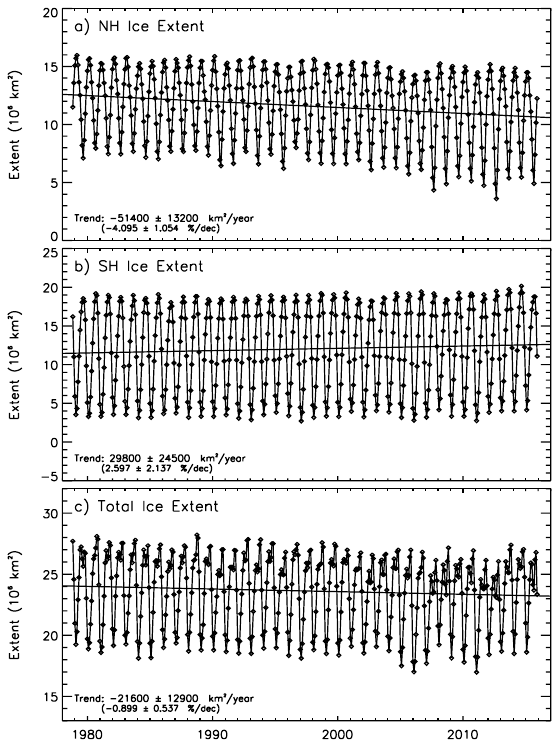
Figure 6. Monthly average sea ice extent from passive microwave data in (a) the Arctic; (b) the Antarctic; and (c) both hemispheres by combining Arctic and Antarctic contributions for each